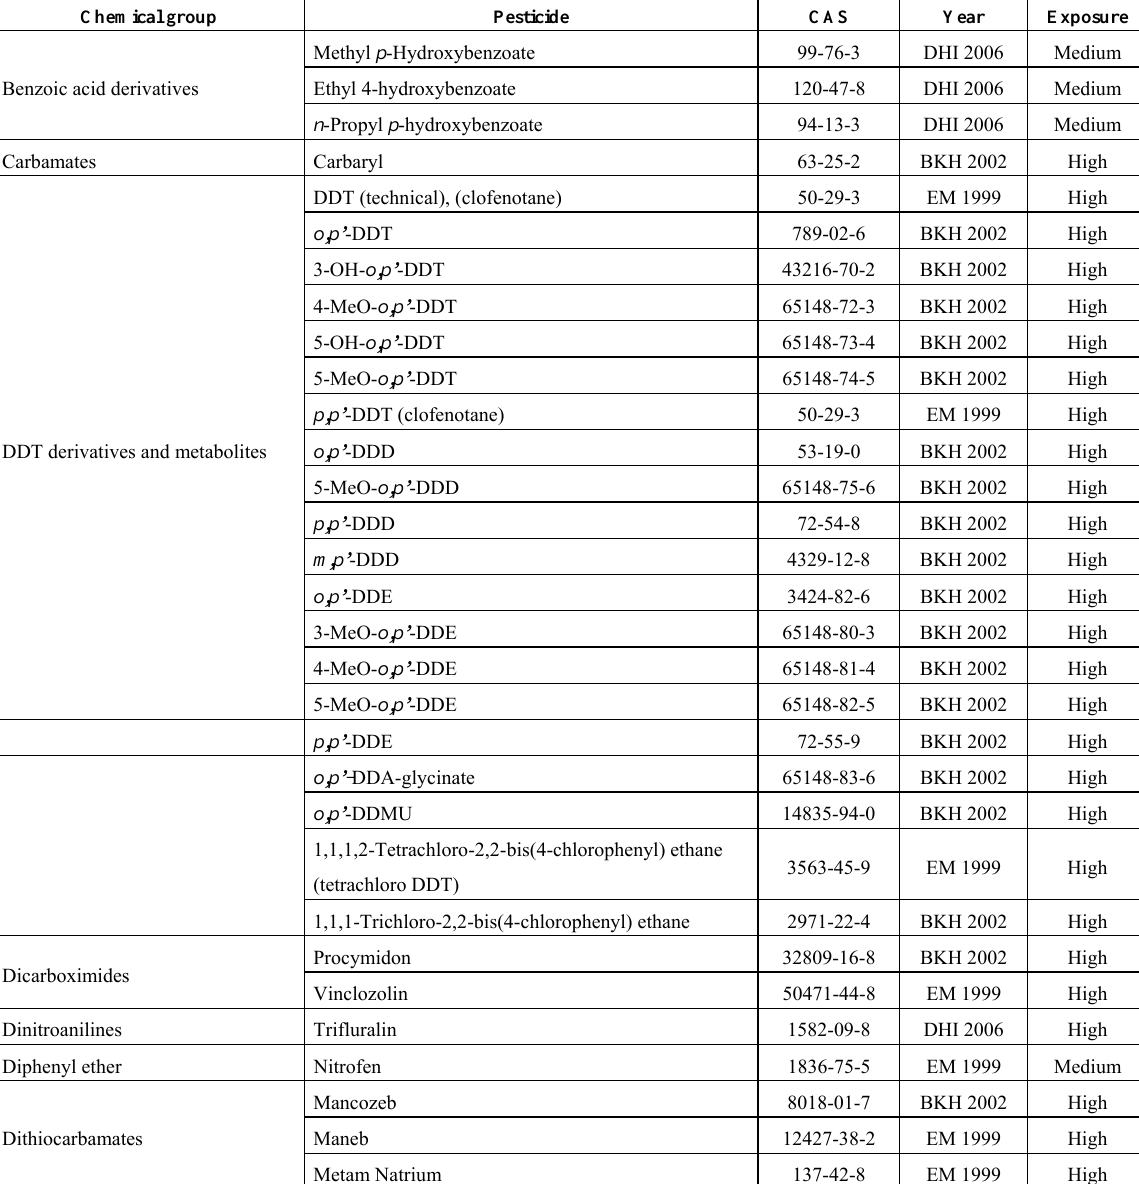
Table 1. Endocrine disrupting pesticides—Category